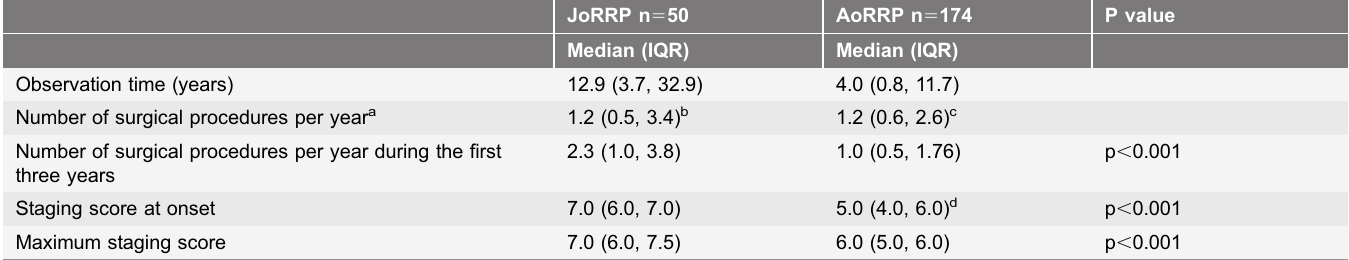
Table 2. Patient characteristics, n 5